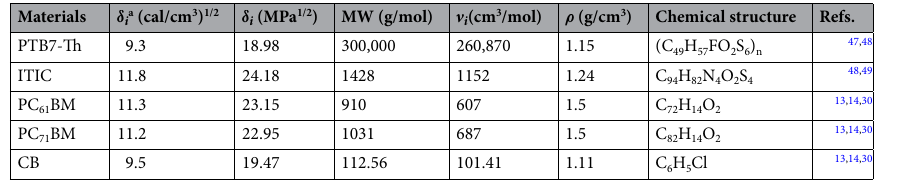
Table 1. Solubility parameter ( δ i ), molecular weight (MW), molar volume ( v i ), density ( ρ ), chemical structure and reference for materials. Here, MW is M n in the case of PTB7-Th. a Note that this solubility parameter with dimension of (cal/cm 3 ) 1/2 is used for Eq.